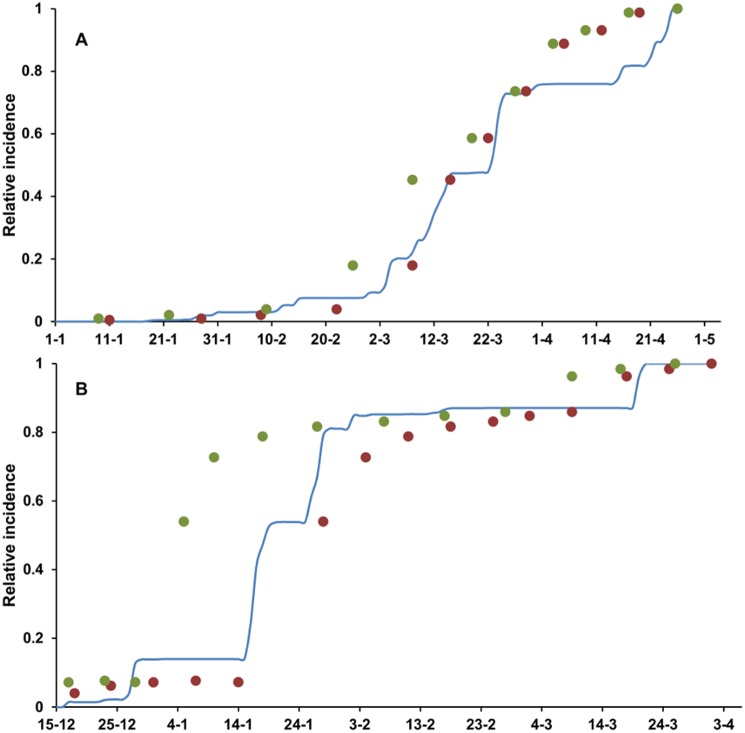
Comparison between model output and scab observed on loquat fruit in southeastern Spain.(A) data from 2011 and (B) data from 2012. Blue lines represent the rescaled infection predicted by the model as the seasonal summation of the lesion units with latent infections (ΣLULI). Points represent rescaled incidence of loquat fruit with scab observed in the orchards; rescaled incidence is shifted back by 21 days (red points) or 420 DD (base 0°C, green points) to account for the latency period, i.e., the time elapsed between infection and visible symptoms in the form of sporulating scab lesions.